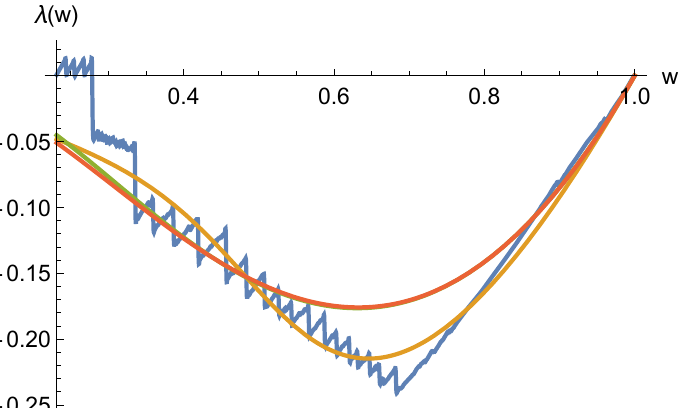
Figure 4. Graphical comparison between theoretical λ ( w ) = w − K ( w ) for SAHARA (yellow), BB2 (green) and 4.2.20 Nelsen (orange) and empirical one